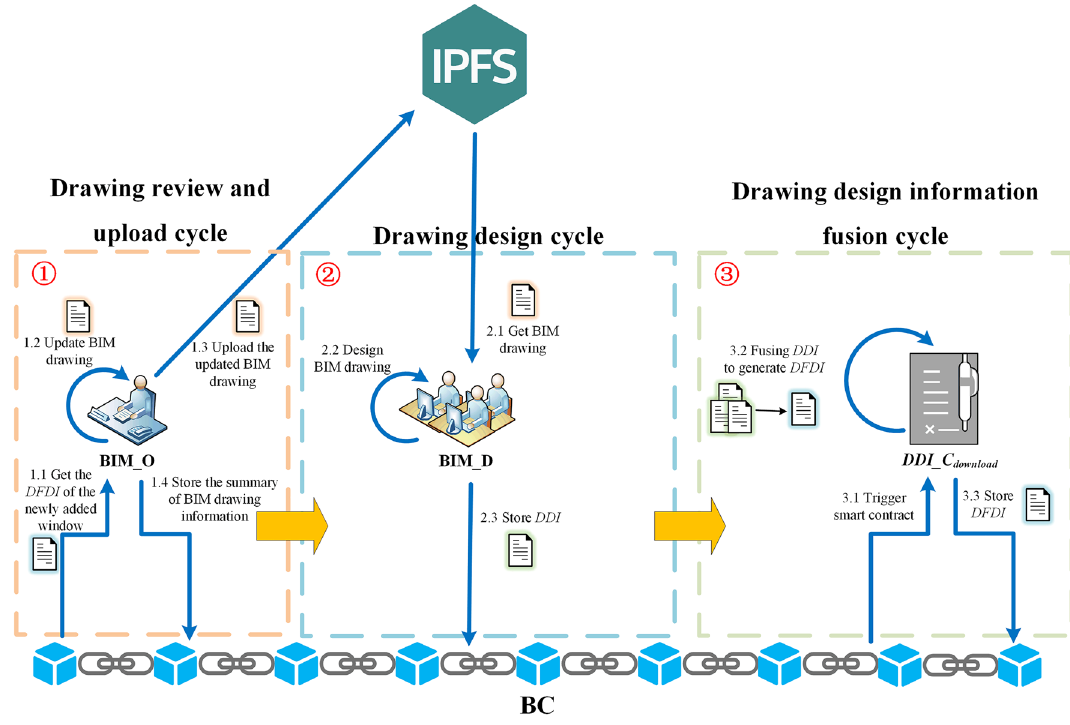
Figure 2. Example of cycle division and